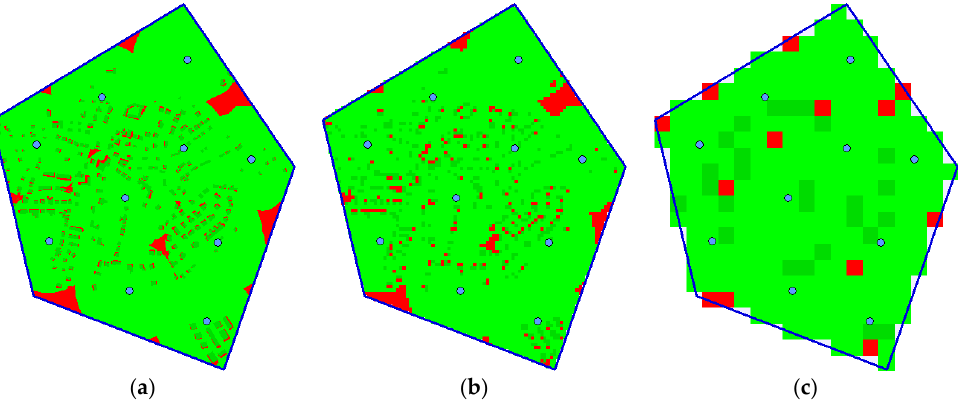
Figure 8. Influence of the size of the rasterization step on the solution evaluation: ( a ) rasterization step (cid:1856) (cid:3045)(cid:3028)(cid:3046)(cid:3047) = 1 ; ( b ) rasterization step (cid:1856) (cid:3045)(cid:3028)(cid:3046)(cid:3047) = 1 0; ( c ) rasterization step (cid:1856) (cid:3045)(cid:3028)(cid:3046)(cid:3047) = 50 .